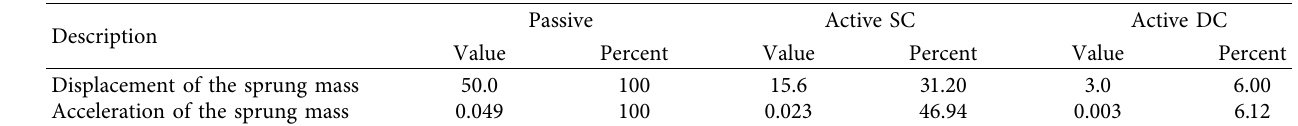
Figure 10: Displacement of the suspension Table 5: The maximum value of case 2.